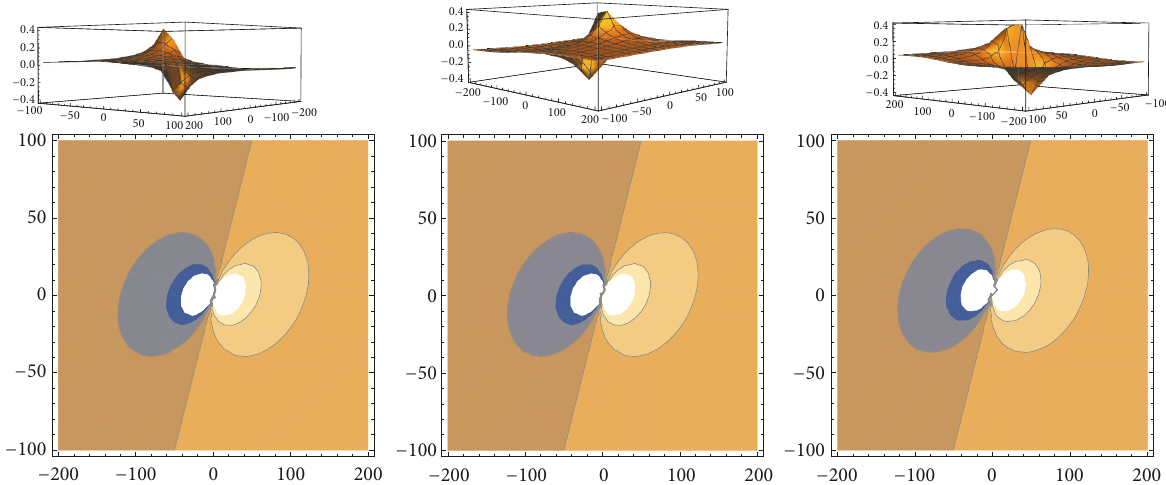
Figure 1: Profiles of equation (1) with 𝑡 = −0.04, 0.1, 3 : 3d plots (top) and contour plots